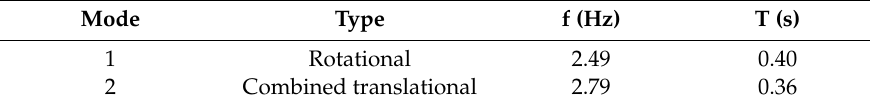
Table 2. Modal results of the “La Viña”